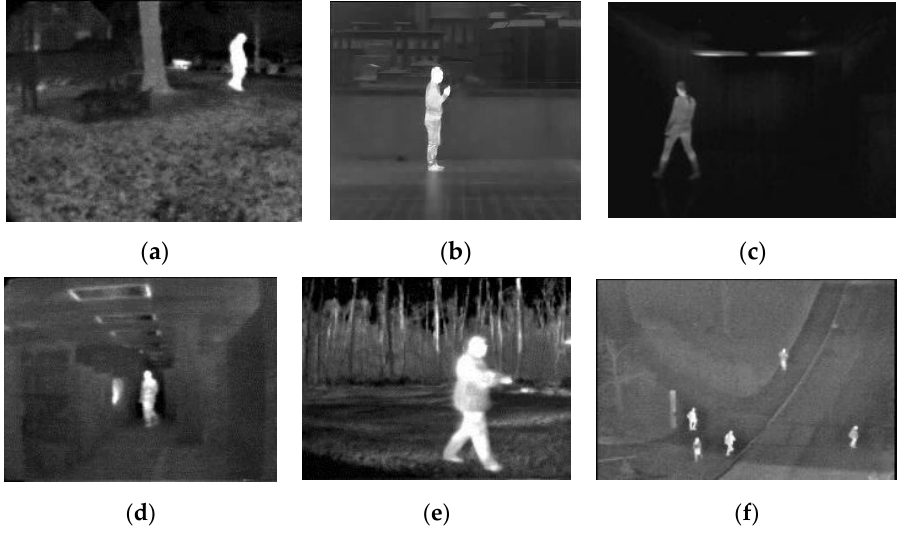
Figure 6. Source thermal infrared images.